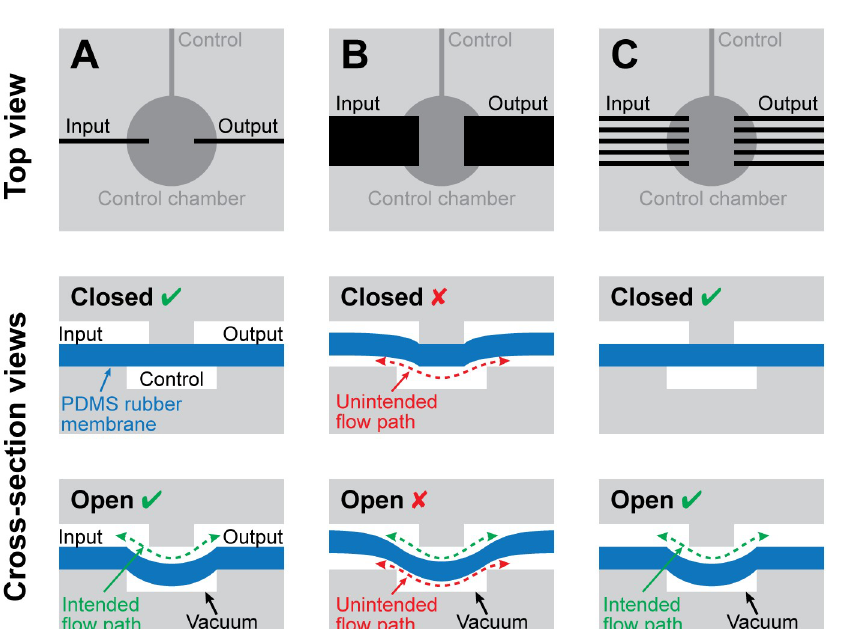
Fig 2. Adapting normally-closed monolithic membrane valves for soft robotic applications. (A) In conventional microfluidic monolithic membrane valves [26], fluid flow between the Input channel and the Output channel is blocked by a flexible silicone membrane (blue). When a vacuum is applied to the Control channel, the silicone membrane is pulled into the Control chamber, opening a path for flow between the Input and Output channels (green dashed arrow). Though adequate for microfluidic applications, the rate of air flow through conventional monolithic membrane valves is too small for controlling larger and faster-moving soft robots. (B) Increasing the widths of the Input and Output channels significantly increases the rate of flow through the valve, but this change brings an undesirable side effect: the silicone membrane can stretch into the Input and Output channels as if they were Control chambers, creating unintentional flow paths (red dashed arrows). (C) Using multiple narrow-width Input and Output channels in parallel eliminates the risk of unintentional flow paths while still maintaining a high flow rate suitable for use controlling soft robotic